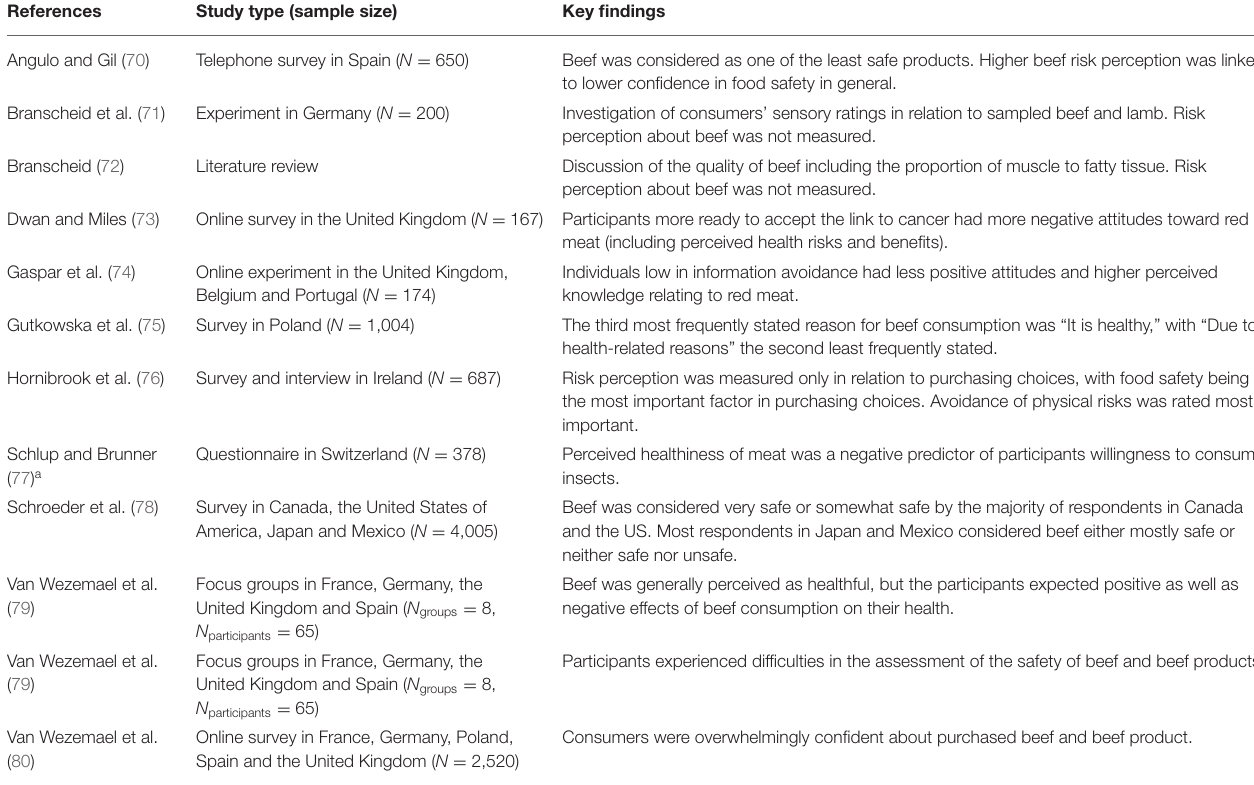
TABLE 2 | Overview of the publications selected as relevant to risk perception relating to red meat in the literature